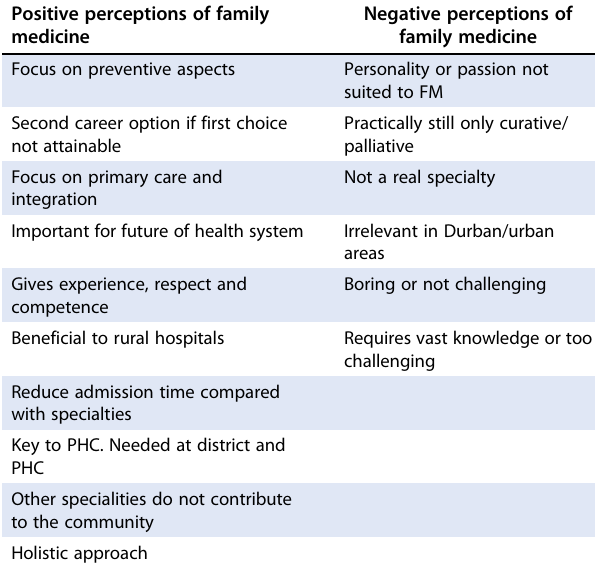
Table 3: Positive and negative perceptions of final year medical students concerning family medicine Positive perceptions of family